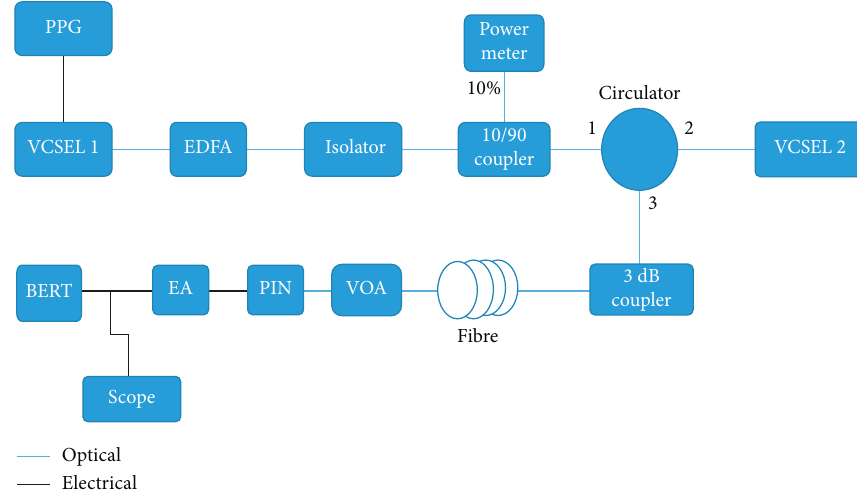
Figure 5: All optical VCSEL-to-VCSEL wavelength conversion